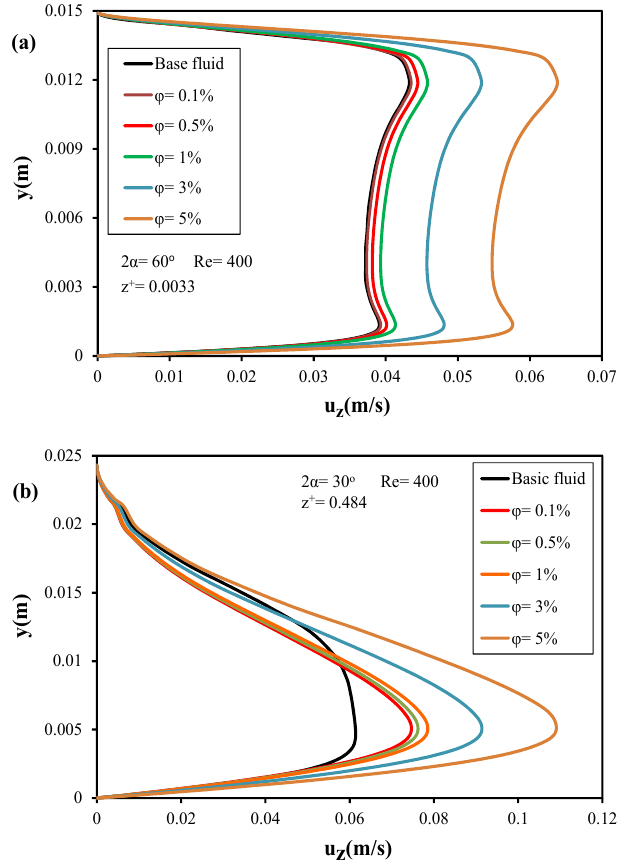
Fig. 10. The velocity profile of fluids on the symmetry surface at the entrance (a) and near the end (b) of the channels.